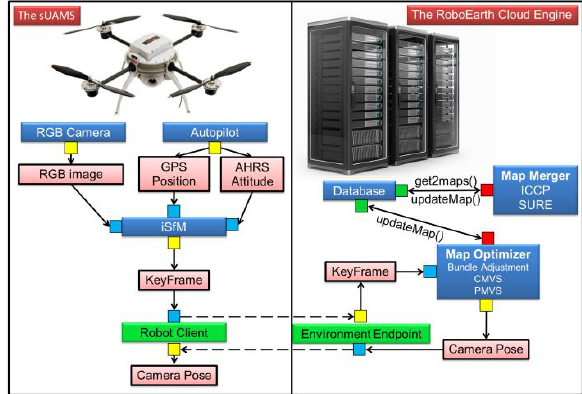
Figure 1: Blue rectangles depict ROS nodes, green rectangles for the RCE’s endpoints, red rectangles for topics, small yellow squares for topic publishers, small blue squares for topic subscribers, small green squares for service servers, and small red squares for server clients. The direction of the arrows indicates the flow of data from the publishers to the topics and topics to subscribers, and arrows with labels connect service servers to service clients. Notably, this architecture was derived from the developers of the RCE (Gherardi et al.,